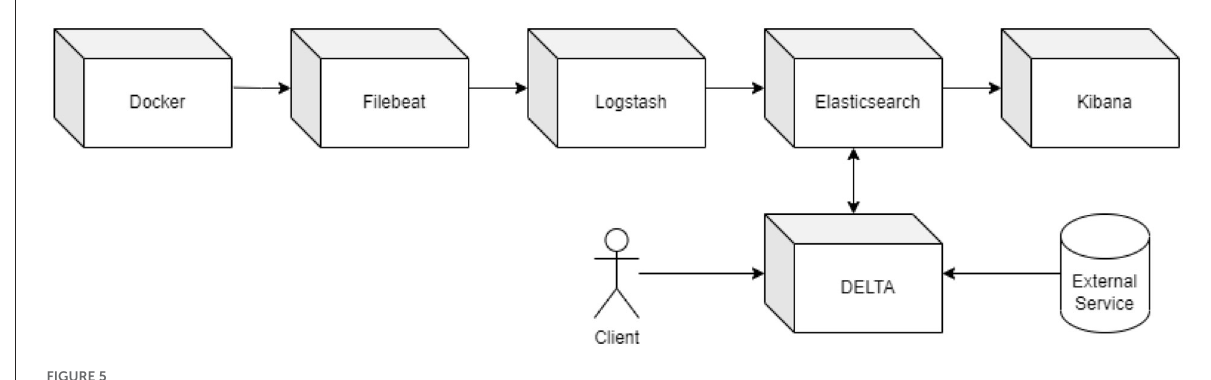
FIGURE5 Structure of the DELTA